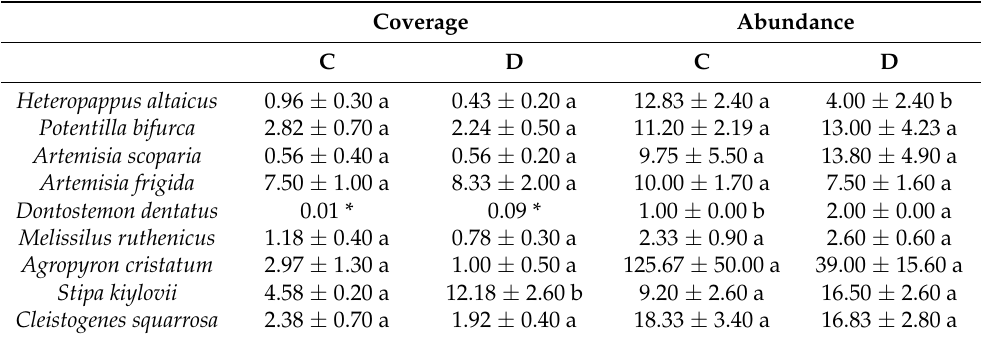
Table 1. The coverage and abundance of dominant plant species in control and drought treatment in the recovery